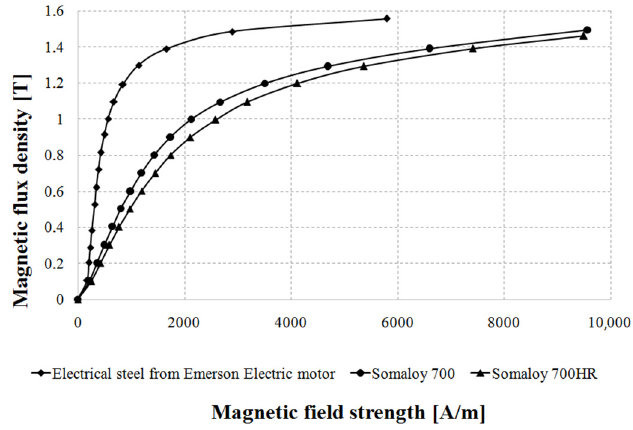
Figure 5. DC magnetization curves for Emerson Electric steel, Somaloy 700 and Somaloy 700HR.